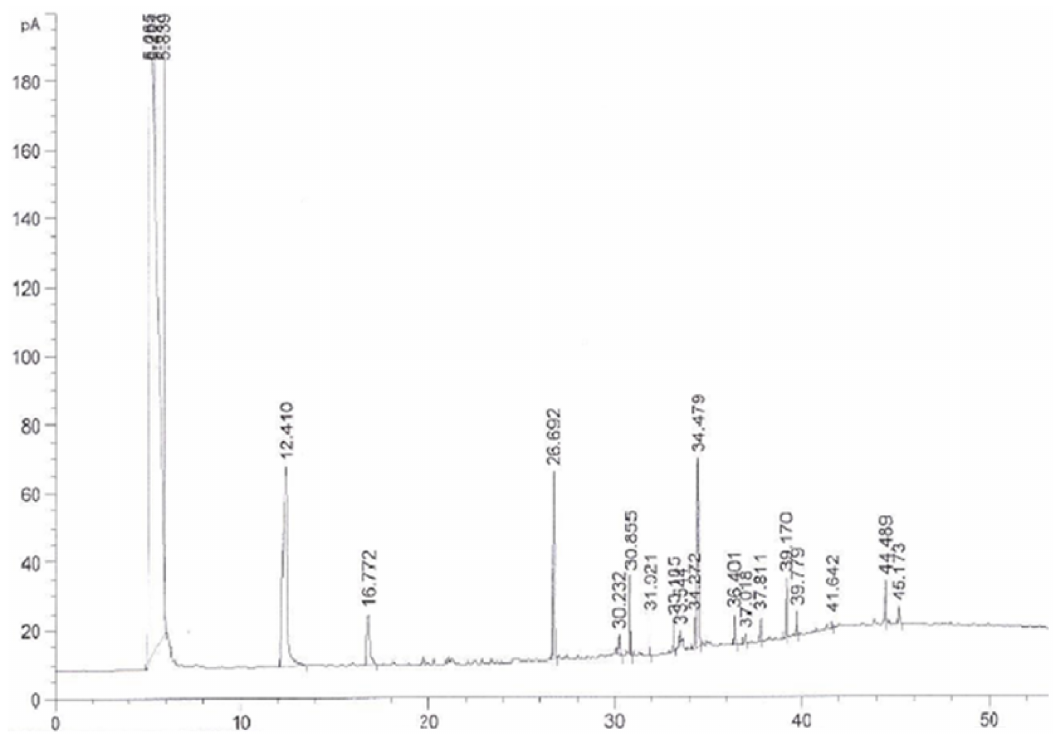
Figure 9. Gas chromatography–mass spectrometry (GC-MS) of Scenedesmus quadricauda lipid